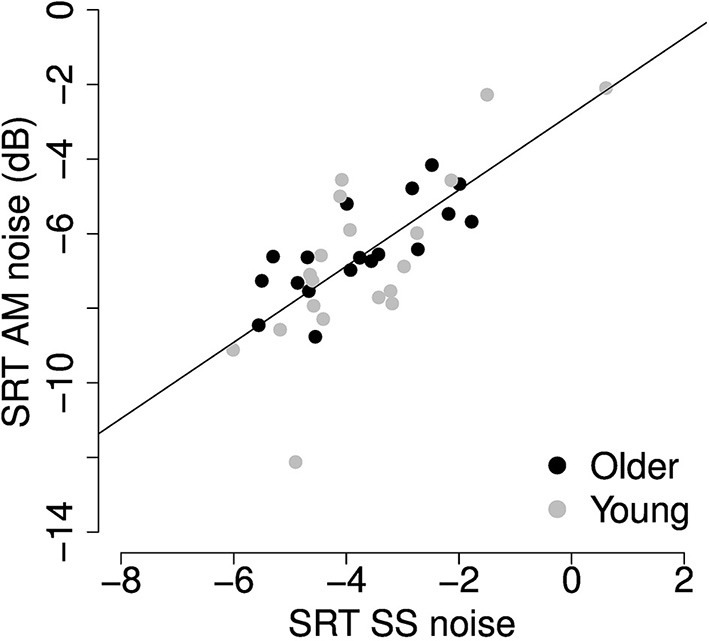
Scatter plot of SRTs in SS and AM noise reveals a strong correlation (r = 0.736, p < 0.001) between performance in the two noise maskers.